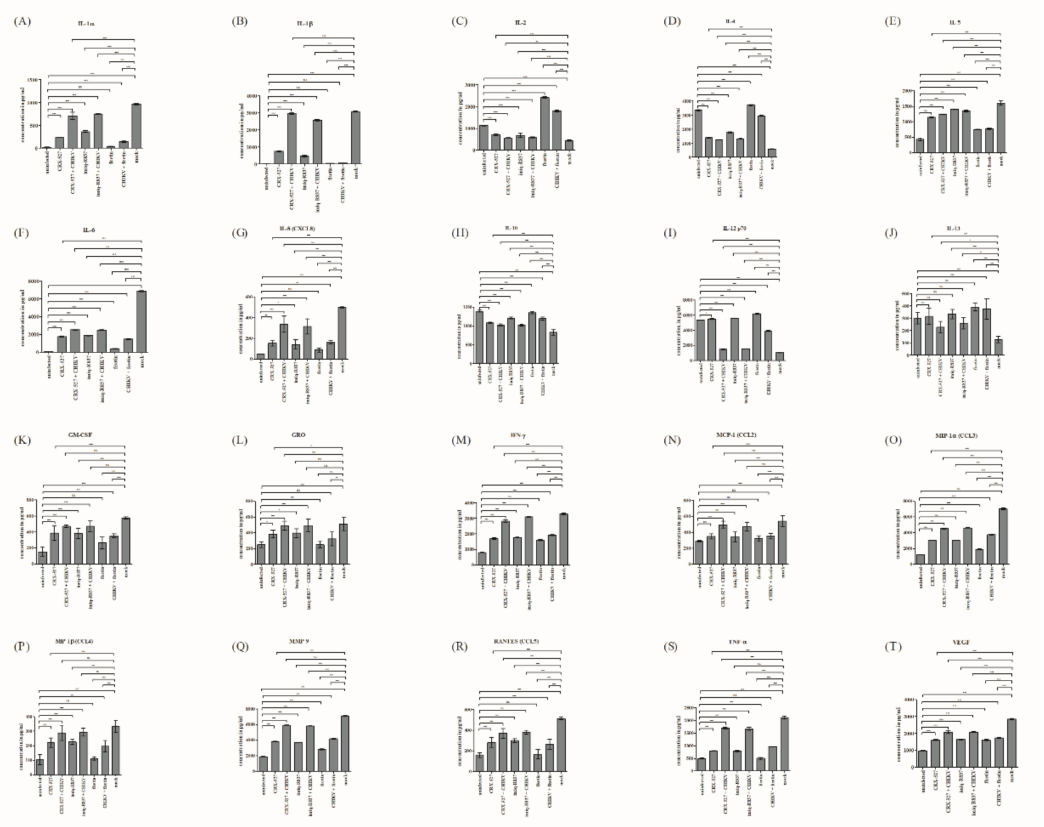
Figure 5. The cytokines and chemokines level in pg/mL. ( A ) IL-1 α , ( B ) IL-1 β , ( C ) IL-2, ( D ) IL-4, ( E ) IL-5, ( F ) IL-6, ( G ) IL-8, ( H ) IL-10, ( I ) IL-12, ( J ) IL-13, ( K ) GM-CSF, ( L ) GRO, ( M ) IFN- γ , ( N ) MCP-1, ( O ) MIP-1 α , ( P ) MIP-1 β , ( Q ) MMP-9, ( R ) RANTES, ( S ) TNF- α , and ( T ) VEGF at 48 hpi. The concentration of chemokines/cytokines was interpolated from the standard curve of respective chemokines/cytokines standards. CHIKV infection was performed using MOI = 1. Data are represen- tative of quadruplicates and values are expressed as mean ± SD. One-way ANOVA ( p < 0.0001) and Dunnett multiple comparison post-test (* is p < 0.05, ** is p < 0.01 and *** is p < 0.001) were performed by setting uninfected and mock Huh7 cells as an independent